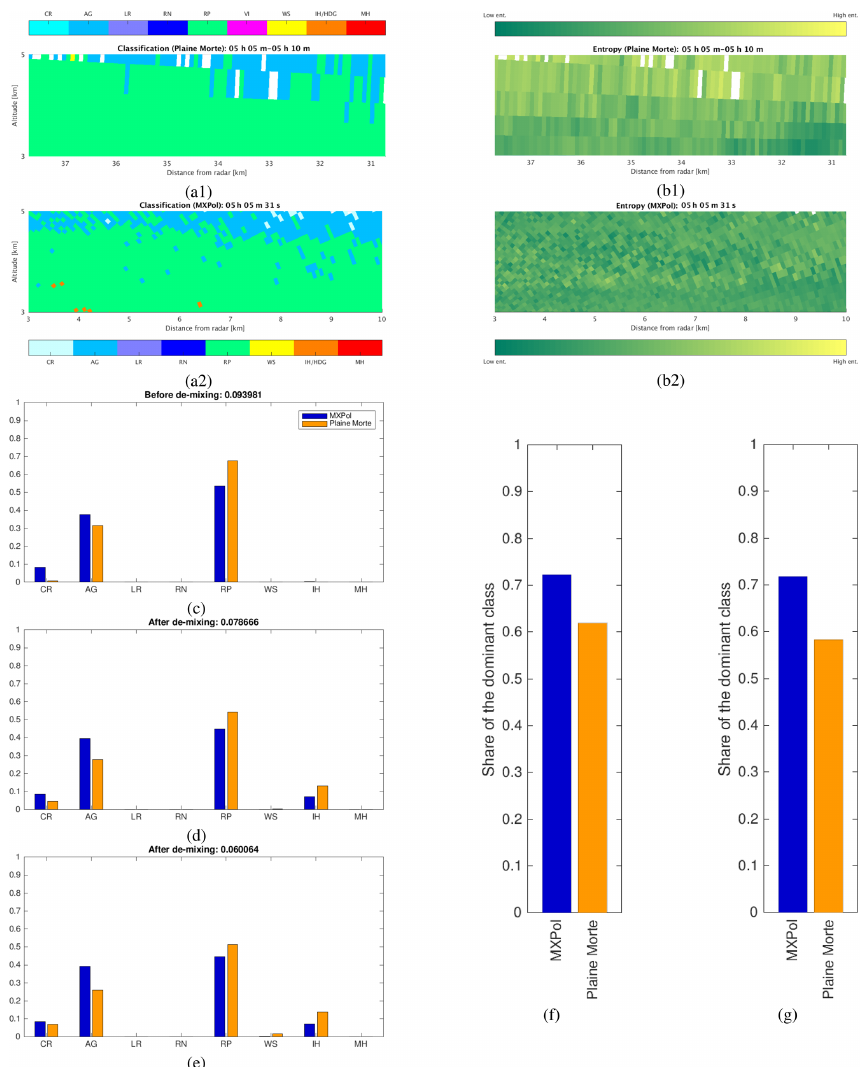
Figure 12. Comparison example in terms of classification (a) and entropy (b) between Plaine Morte (1) and MXPol (2), followed by the quantitative matching analysis before de-mixing (c) , after de-mixing with only three dominant components (d) and after de-mixing with all components (e) , and quantitative measure of mixing ratio with only three components (f) and with all components (g)